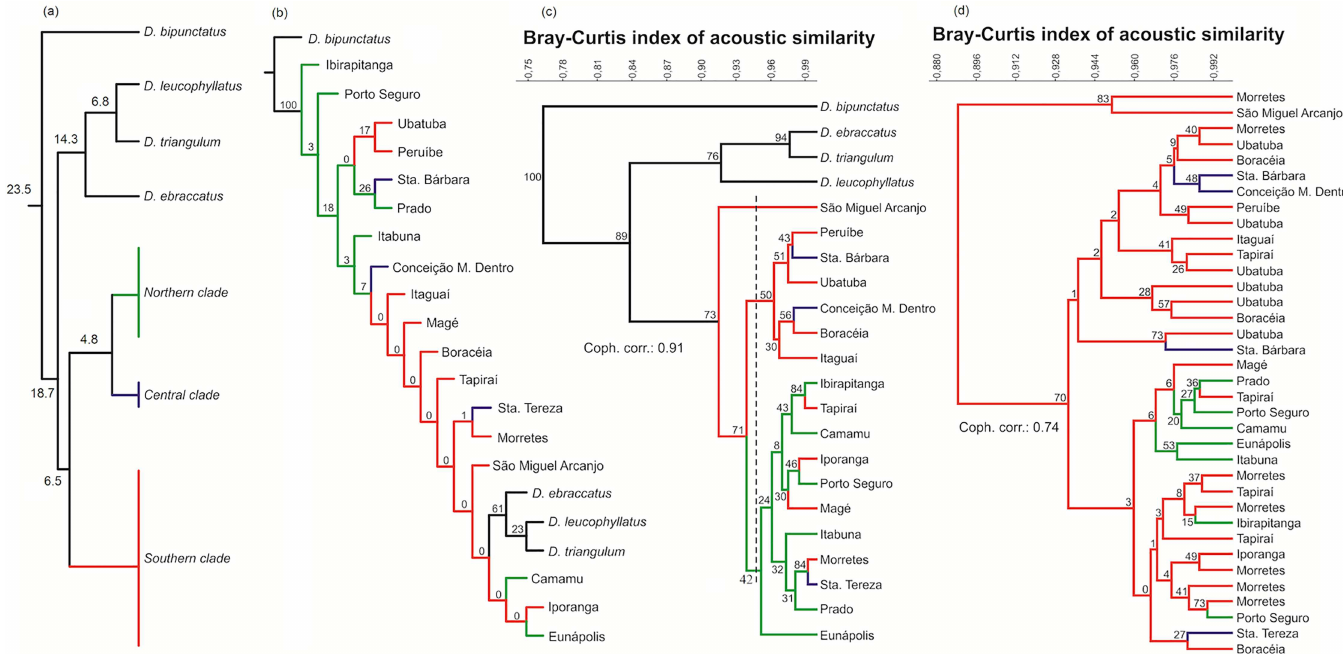
Fig 2. Different arrangements of species and populations of Dendropsophus . (a) Phylogeneticrepresentation of phylogeographicalclades of Dendropsophus elegans (as in [26]) and closely related species(as in [29]). Numbers at nodes are estimates of the divergence time. (b) Phylogenetic tree basedon acoustic data using the maximum parsimony analysismethod. Numbers at nodesare values resulting from a standardbootstrap resampling. (c) Dendrogram with four outgroup Dendropsophus species and 18 D . elegans populationsresulting from a hierarchical cluster analysisbasedon similarities in call properties(dashedvertical line on the three main branches). (d) Dendrogramof 37 D . elegans individualsresultingfrom a hierarchical cluster analysis basedon similaritiesin acousticproperties.In both dendrograms, the numbers at nodes are values obtainedfrom standardbootstrapresampling.The colors of the branches correspond to each individual’s phylogeographicalclade (as in [26]): northern(green), central (blue), and